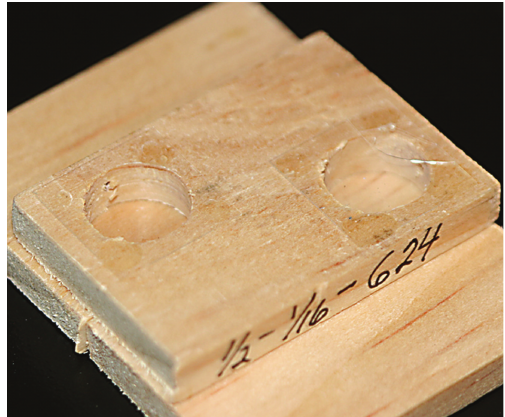
Figure 3: Artificial Nest: middle section with top and bottom pieces